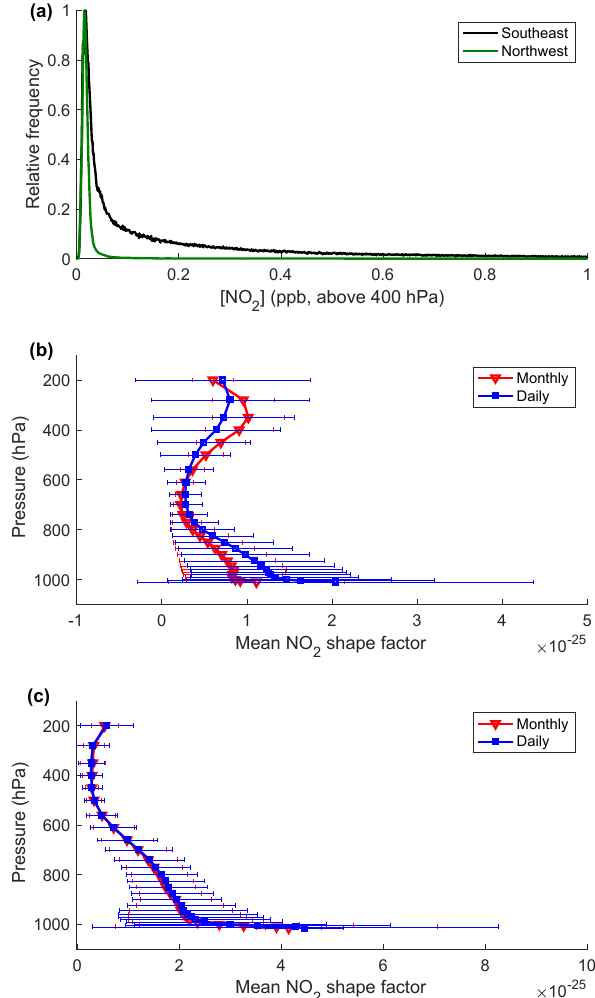
Figure 5. (a) Frequency distribution (normalized to maximum) of average NO 2 above 400hPa in the a priori profiles for the southeast- ern and northwestern US, from June to August 2012. (b, c) Mean a priori NO 2 shape factors over the southeastern US (b) and north- western US (c) for June–August 2012. Shape factors are defined as the NO 2 profile in a mixing ratio divided by its integral in molec.cm − 2 . The error bars are ± 1 σ . The regions (southeastern and northwestern US) are shown in Fig.